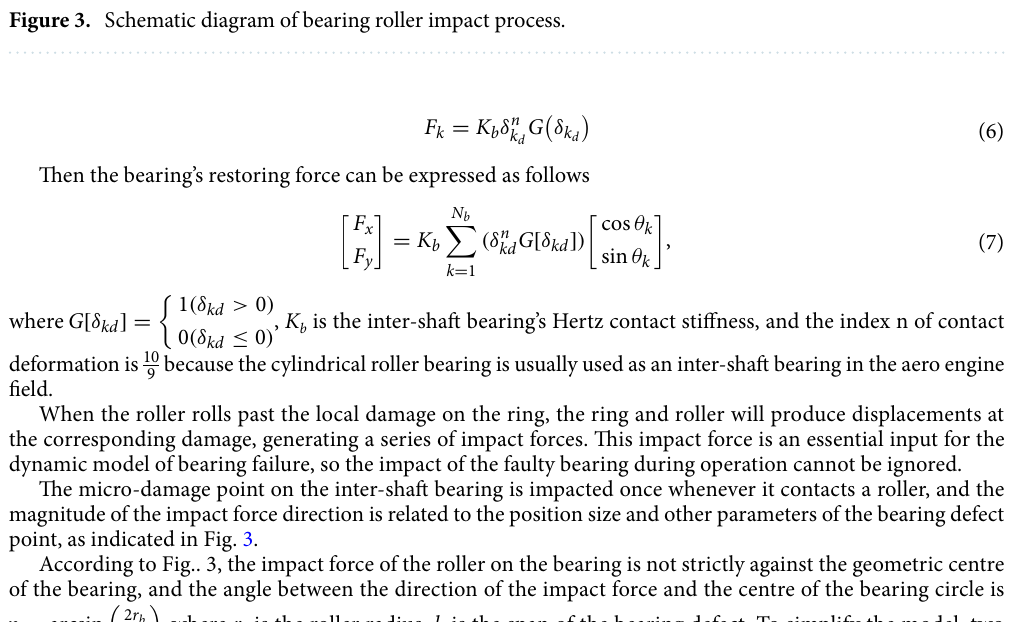
Figure 3. Schematic diagram of bearing roller impact